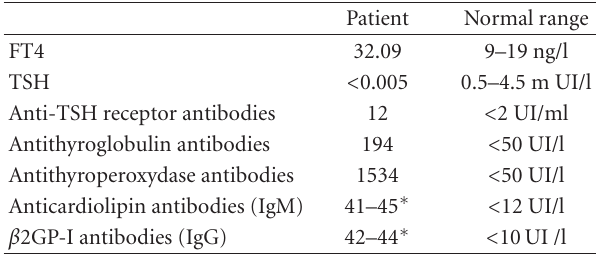
Table 1: Biological characteristic of the